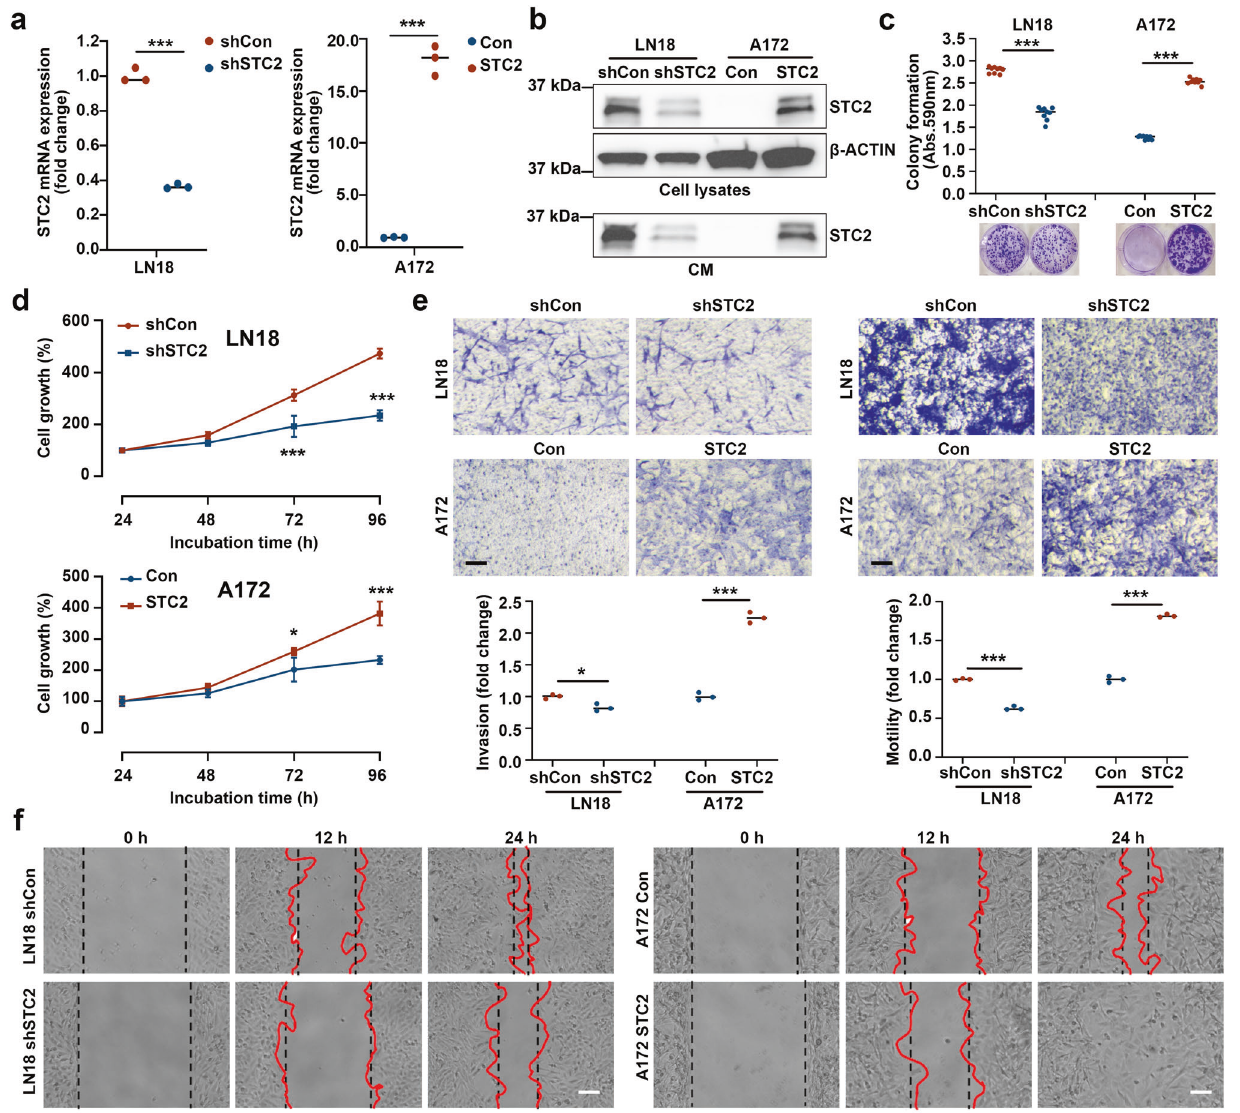
Fig. 2 Overexpression of STC2 results in invasive phenotypes of GBM cell lines. a , b STC2 mRNA ( a ) and protein ( b ) expression was validated after modulation of STC2. LN18 cell was transfected with pRS-sh STC2 to knockdown STC2 whereas A172 cell was transfected with Myc-DDK- tagged- STC2 to overexpress STC2 . Means ± SD; n = 3 biological replicates; Student ’ s two tailed t-test, *** p < 0.001. c Cells were seeded to 6-well plates at a density of 1000 cells per well and colony formation was determined after 10 days. Absorbance at 590 nm was measured after dissolving with 10% acetic acid. Means ± SD; n = 3 biological replicates; Student ’ s two tailed t-test, *** p < 0.001. d Cell growth rates after STC2 modulation were determined by MTT assay. Means ± SD; n = 12 biological replicates. Student ’ s two tailed t-test, * p < 0.05, *** p < 0.001. e In vitro invasion and motility were determined onto Matrigel-coated or non-coated Transwell chambers for 48 h. Scale bar = 100 µm. Means ± SD; n = 5 biological replicates; Student ’ s two tailed t-test, * p < 0.05, *** p < 0.001. f In vitro migration was determined for 24 h after STC2 modulation. Scale bar = 100